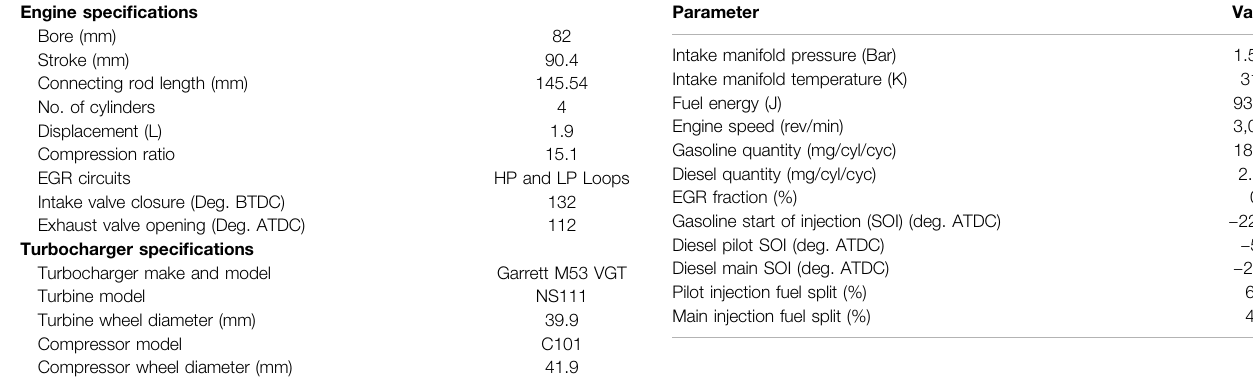
TABLE 1 | General motors Z19 DTH light-duty engine and Garrett M53 turbocharger speci fi cations. Engine speci fi cations Bore (mm)